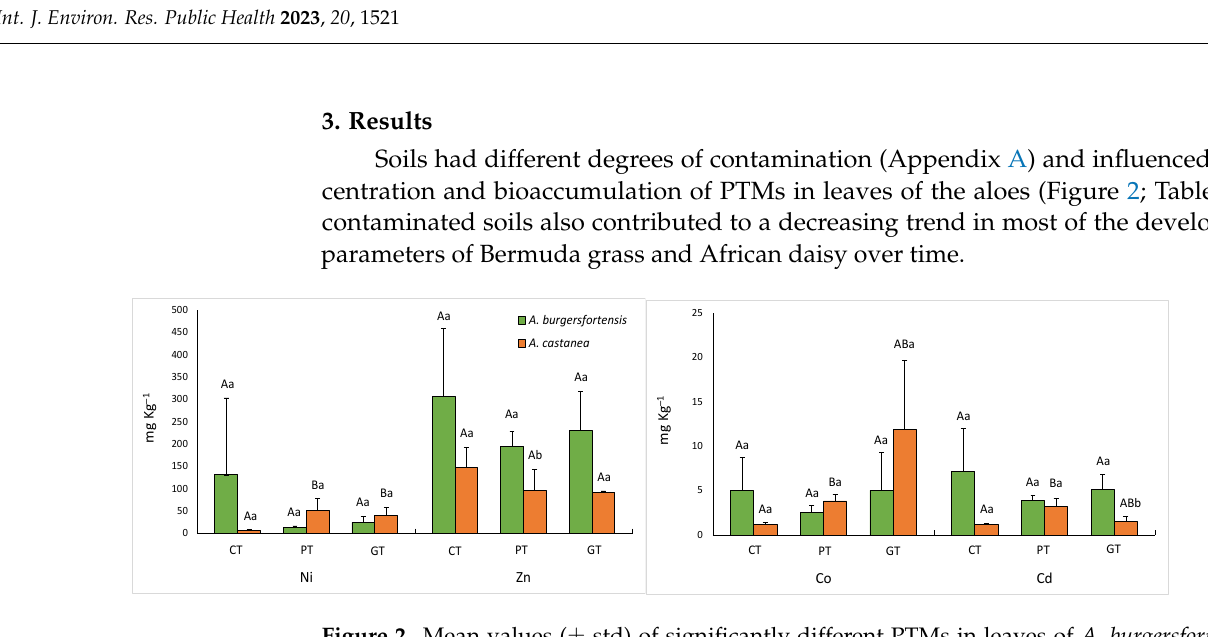
Figure 2. Mean values ( ± std) of significantly different PTMs in leaves of A. burgersfortensis and A. castanea . Different upper-case letters: significant difference ( p < 5%) for a PTM in the same aloe species in different soil treatments. CT = control, PT = platinum tailings, and GT = gold tailings. Different lower-case letters: significant difference for a PTM between aloe species in the same soil treatment. Table 1. Bioaccumulation factors for the aloe plants in the different soil treatments. Bold values: BAF > 1.